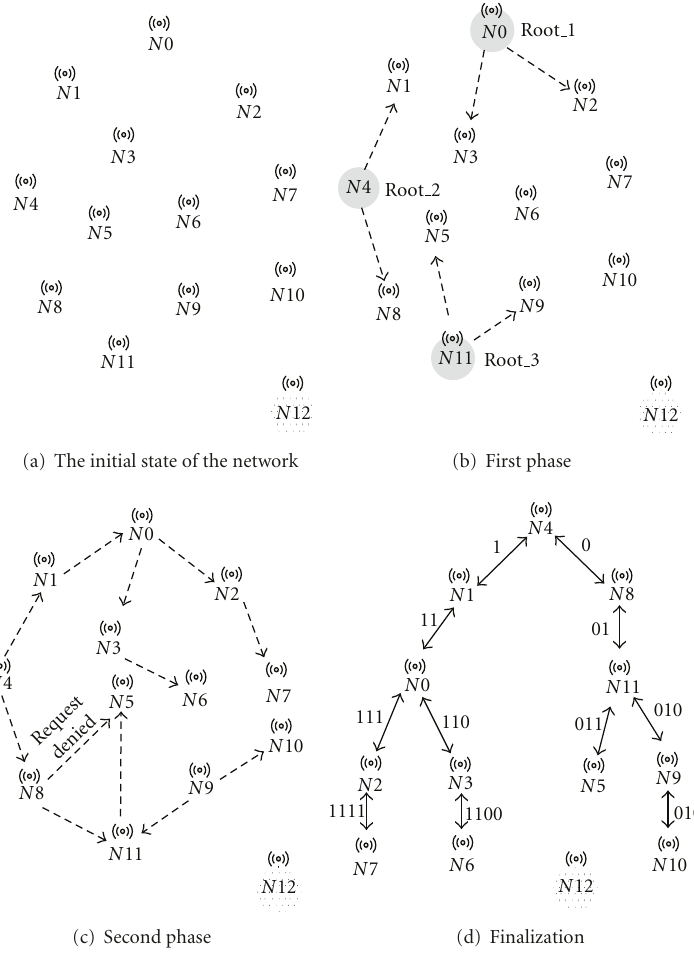
Figure 2: Example of the parallelized binary tree-based